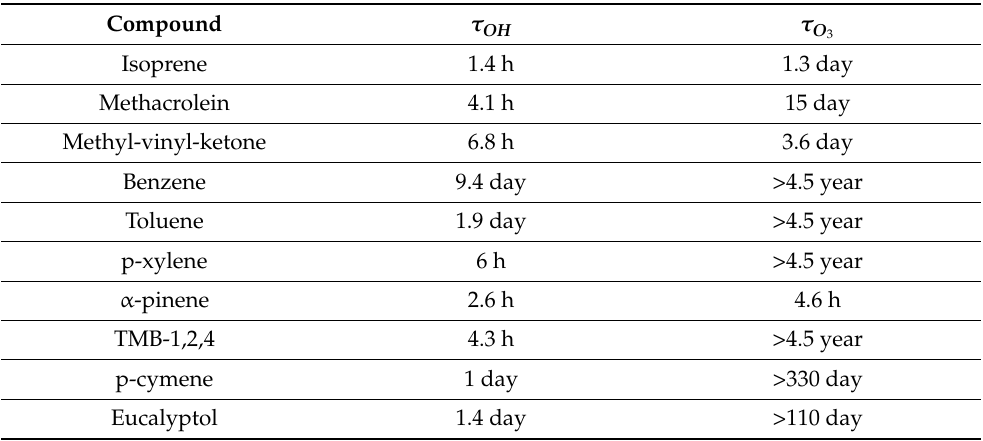
Table 4. Reported lifetime for the observed BVOCs under OH and O 3 oxidation. Obtained from [13,58,59].